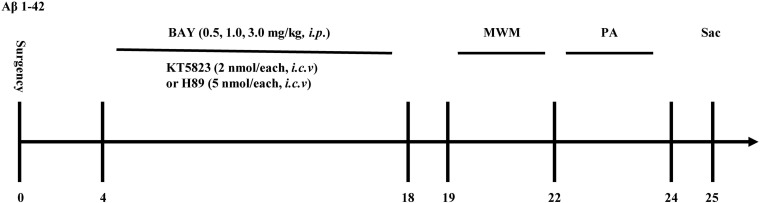
Experimental timeline for drug treatments. One and a half months after microinjection with Aβ1–42 into the cerebroventricle, mice were administrated with Bay 60-7550 for 14 days. H89 and KT5823 were pretreated 30 min before Bay 60-7550 administration every day. All the behavioral tests were performed 24 h after last drug treatment. Behavioral tests were carried out on days 19–24 and then the mice were sacrificed and biochemical assays were performed. MWM, Morris water maze; PA, passive avoidance test; Sac, sacrifice. n = 10 for each experiment.